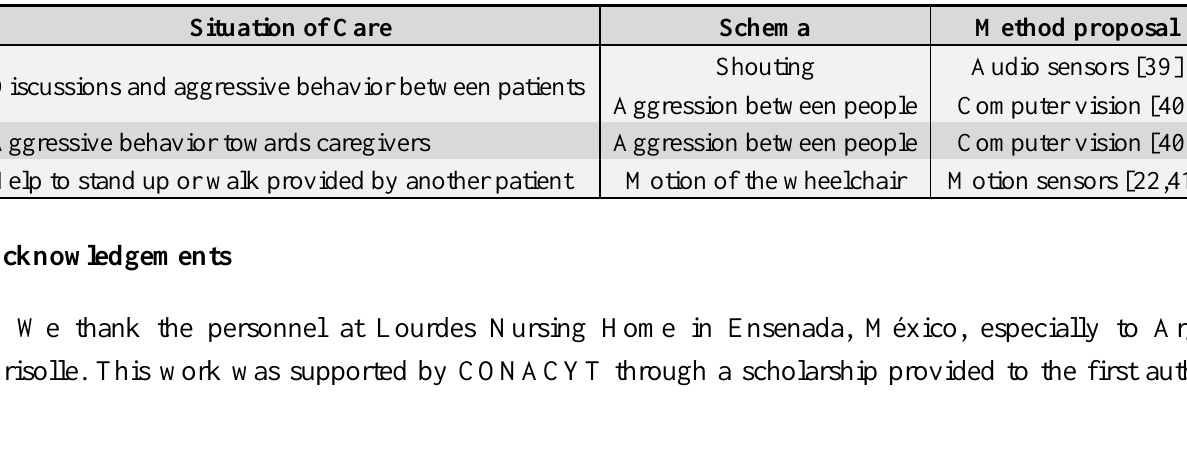
Table 4. Schemes proposed to infer complicated situations of